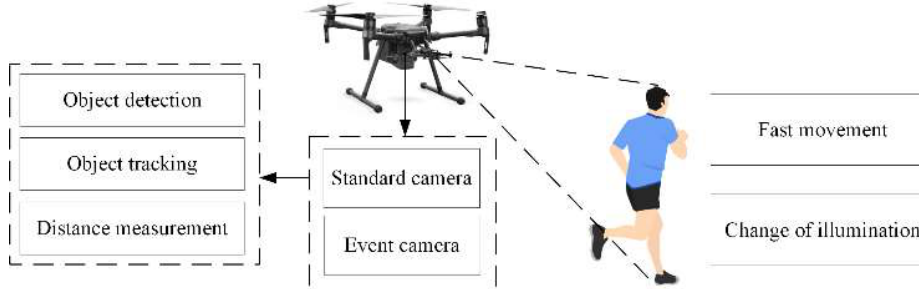
Figure 2. Example of object detection and tracking.